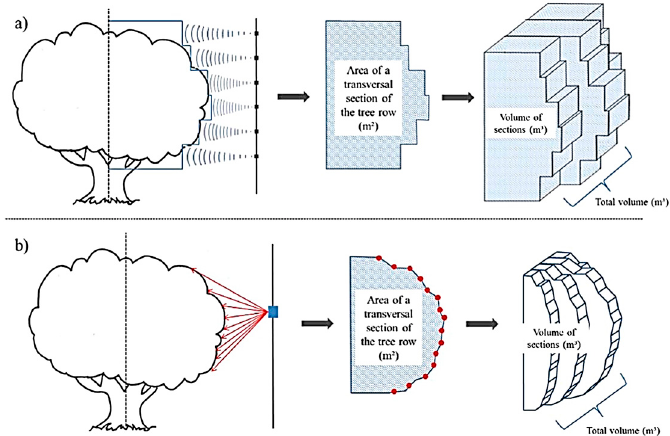
Figure 4. Measurement of canopy volume by using an ultrasonic sensor ( a ) and a laser sensor ( b ) [96] (CC BY 4.0).